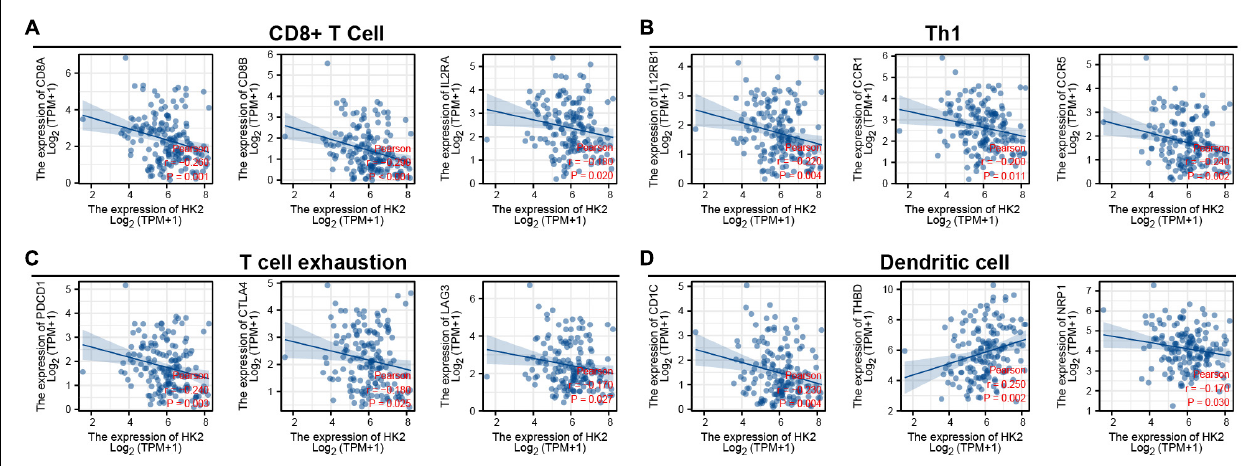
FIGURE 7 | HK2 expression correlated with CD8 + T Cell, Th1, T cell exhaustion and dendritic cell in esophageal carcinoma (ESCA). Markers include CD8A, CD8B, and IL2RA of CD8 + T Cell (A) ; IL12RB1, CCR1 and CCR5 of Th1 (B) ; PDCD1, CTLA4, and LAG3 of T cell exhaustion (C) ; CD1C, THBD and NRP1 of dendritic cell (D)